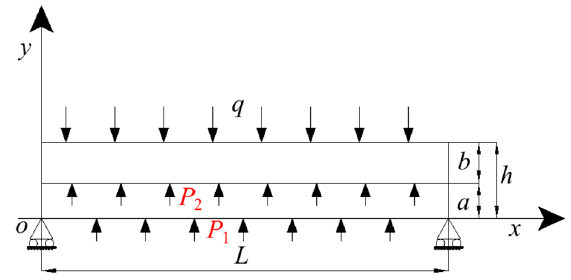
Figure 8. Layered grouting support structure.